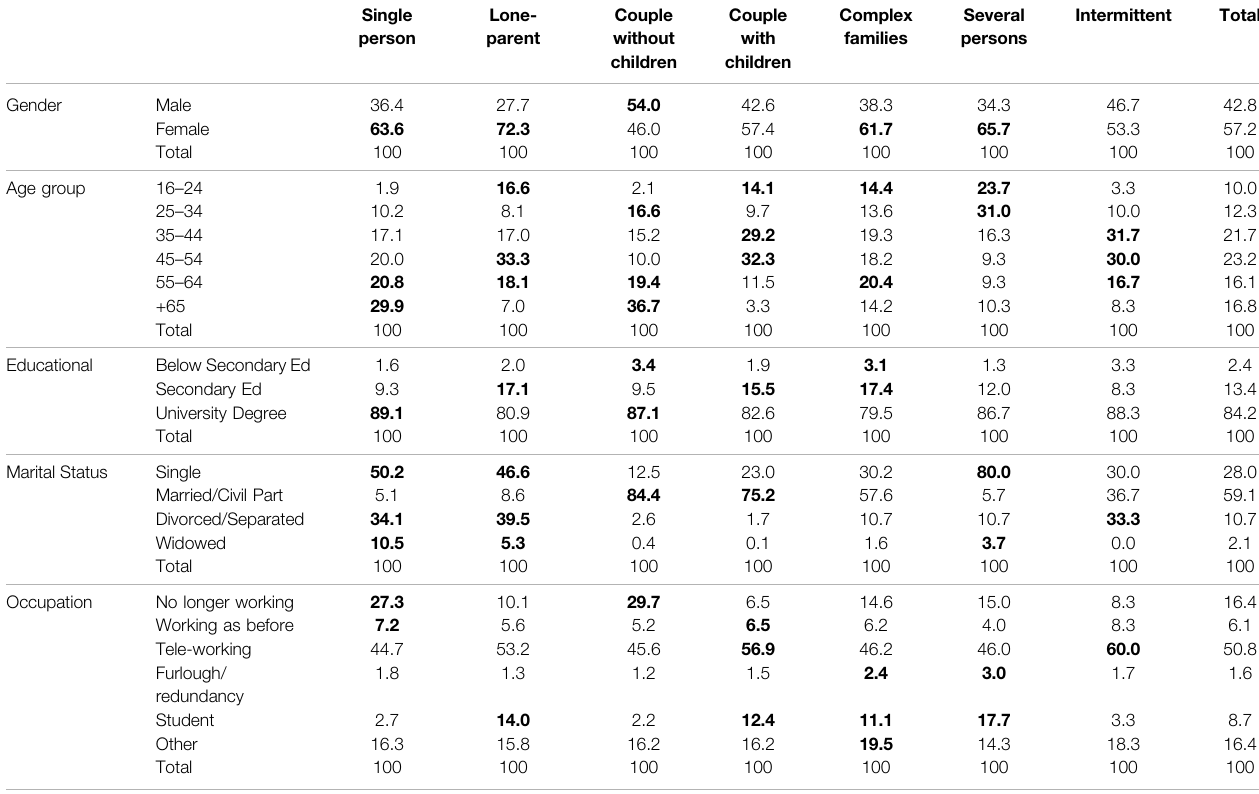
TABLE 1 | Sociodemographic features of household types during lockdown (in %).